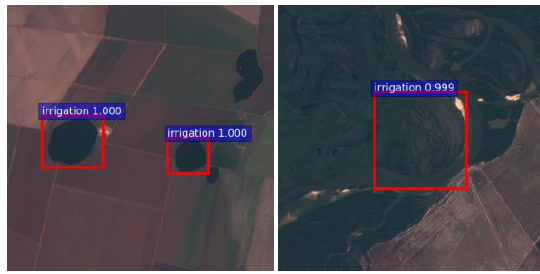
Figure 8. Examples of false detections by PVANET